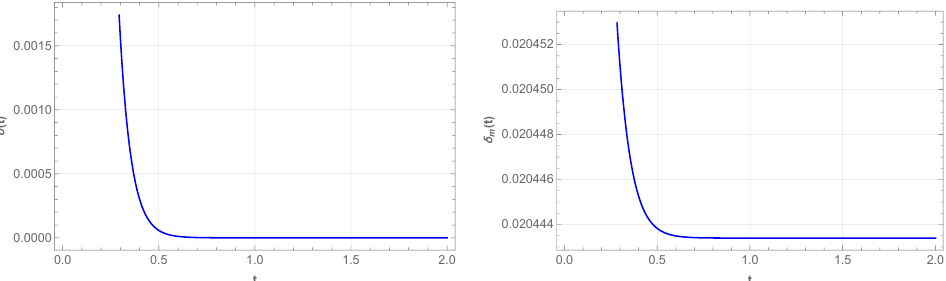
Figure 10. δ ( t ) ( left panel ) and δ m ( t ) ( right panel ) versus cosmic time for Model II. The parameter scheme: α = − 0.30, β = 0.15, λ = 1.01, ρ 0 =